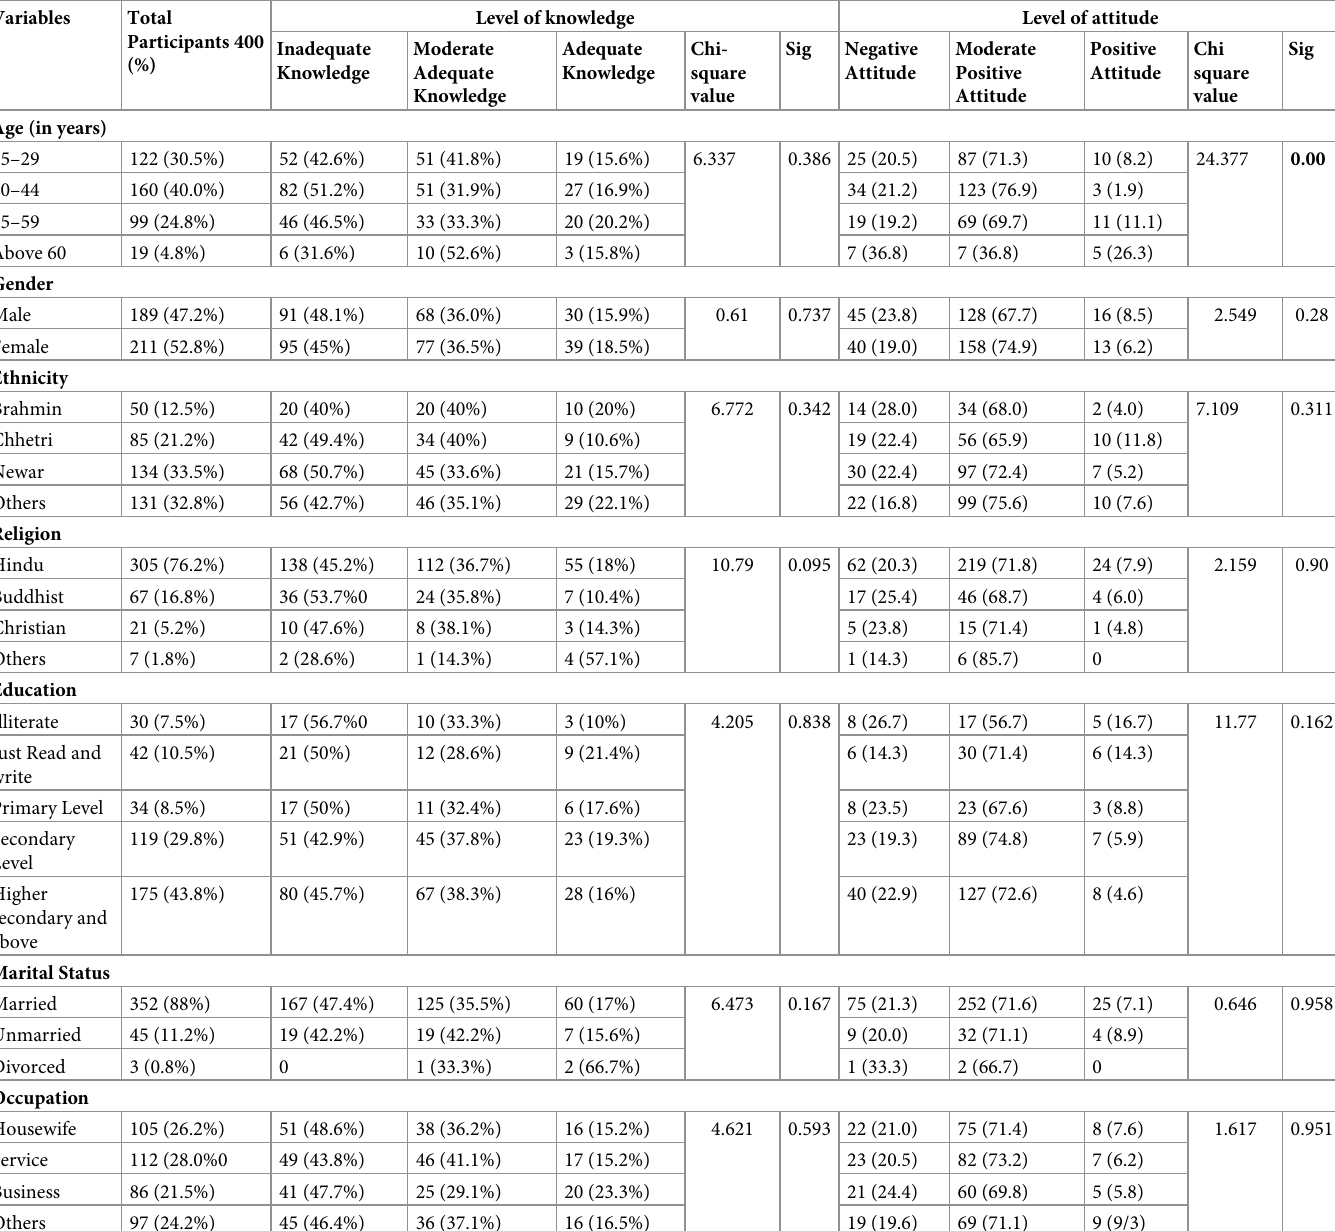
Table 5. Association between the level of knowledge and attitude and their selected socio-demographic